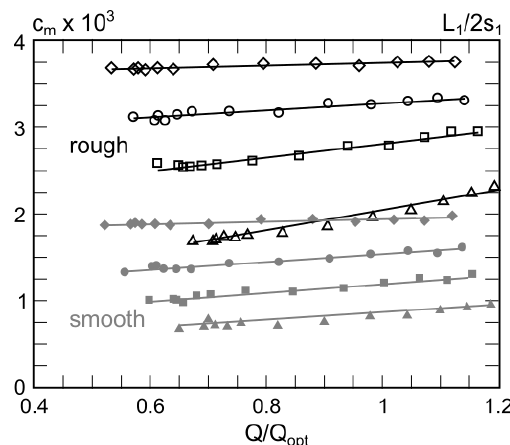
Figure 17. Disk friction coefficient for different specific speed and different capacity ratio in centrifugal pumps. Reproduced from [94], ASME: